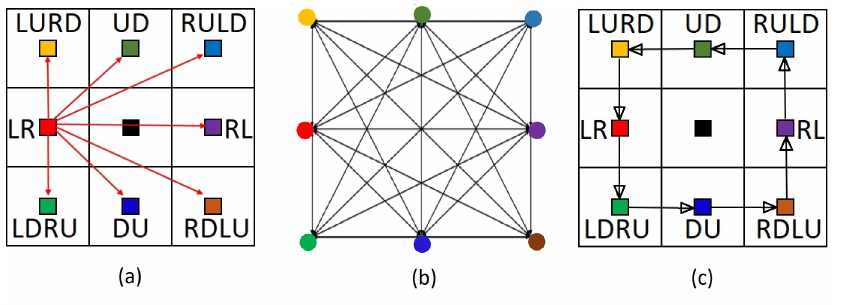
Figure 10. ( a ) Eight counter-clockwise turning edges for LR. ( b ) 56 counter-clockwise turning edges for all eight terminals in a cell. ( c ) The edges in ( b ) can be made by the eight sequential edges shown in ( c